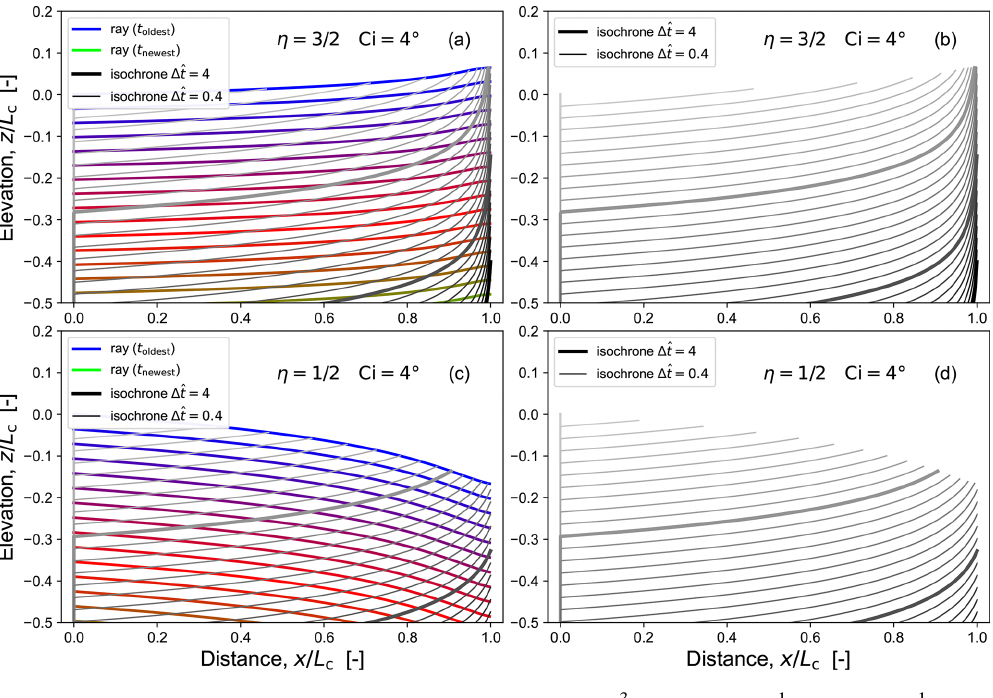
Figure 14. Ray-tracing construction of erosion surfaces or isochrones: (a, b) η = 3 subset of the resolved rays and isochrones is